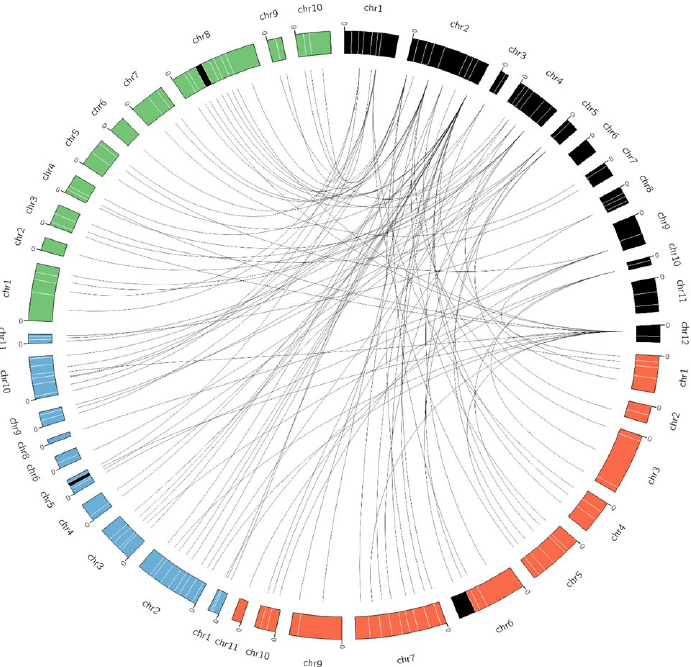
Figure 6. Circos map showing chromosomal position and collinearity of trihelix genes of cowpea, mung bean, adzuki bean and rice chromosomes. The red, green, blue and black represent chromosome of cowpea, mung bean, adzuki bean and rice, respectively. The black line shows connection of the respective orthologs of two species in Vigna and